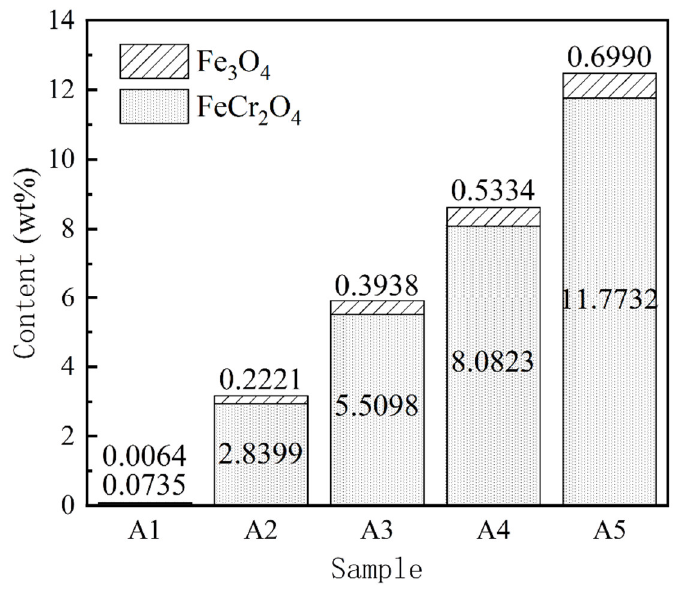
Figure 8. Relationship between Cr 2 O 3 content and the components of spinel at 1500 °C.